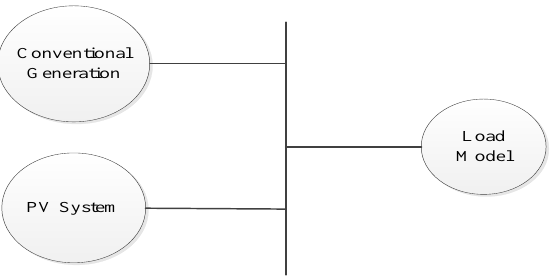
Figure 1. Basic Reliability Evaluation Model for a photovoltaic (PV)-integrated Power System.